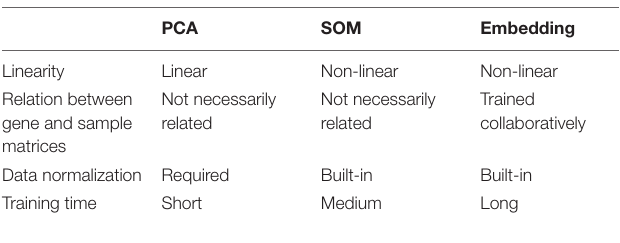
TABLE 1 | Comparison between PCA, SOM, and